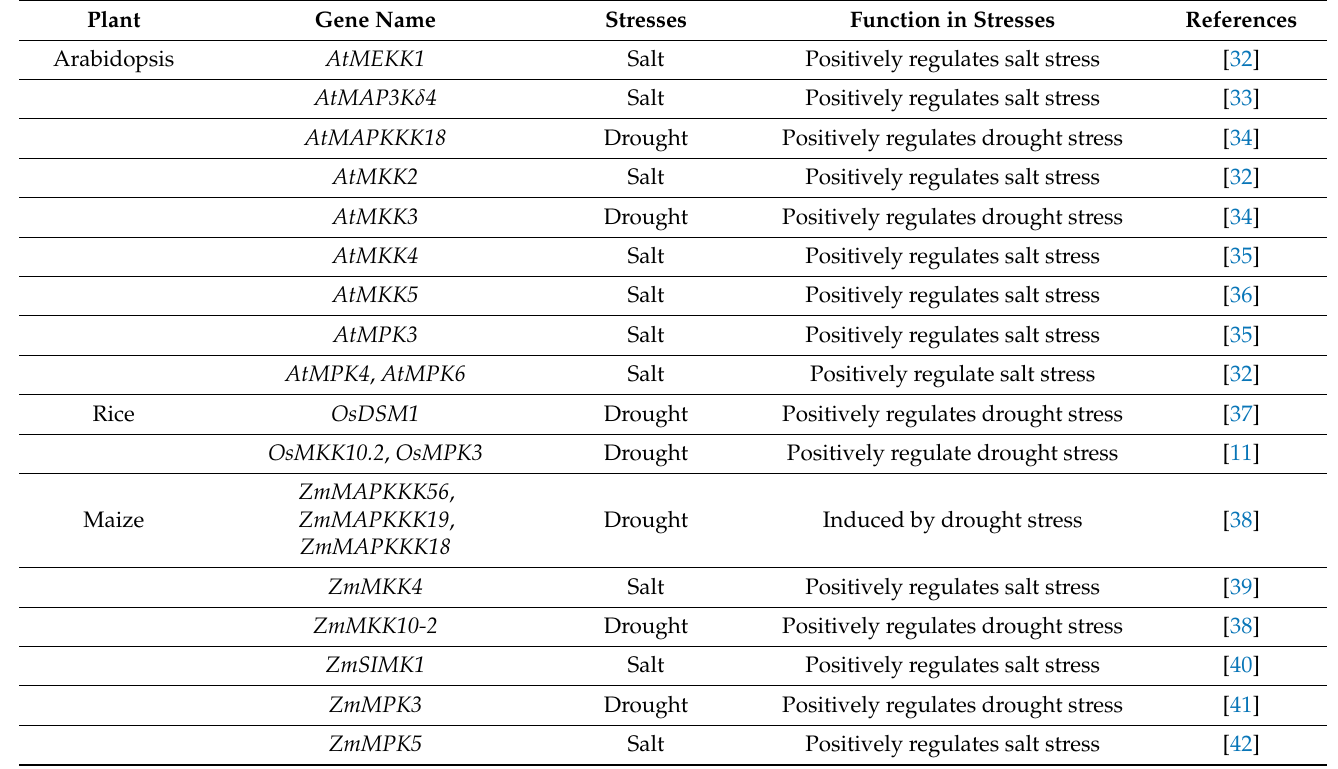
Table 1. Summary of mitogen-activated protein kinase (MAPK) genes involved in salt and drought stress responses in Arabidopsis, rice, maize, cotton, etc.